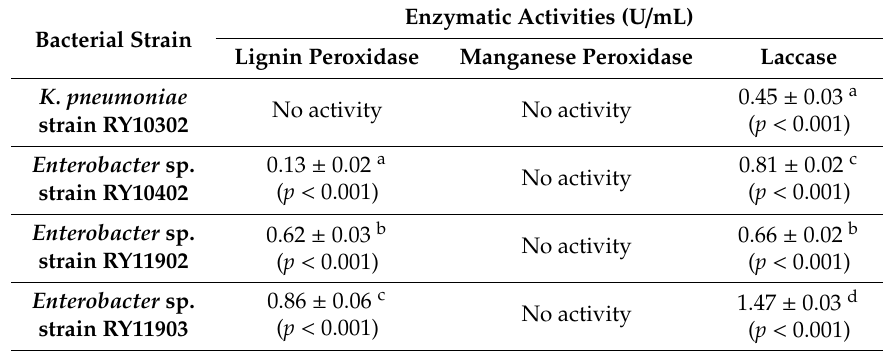
Table 4. Peroxidase and laccase activities of the four dye-decolorizing